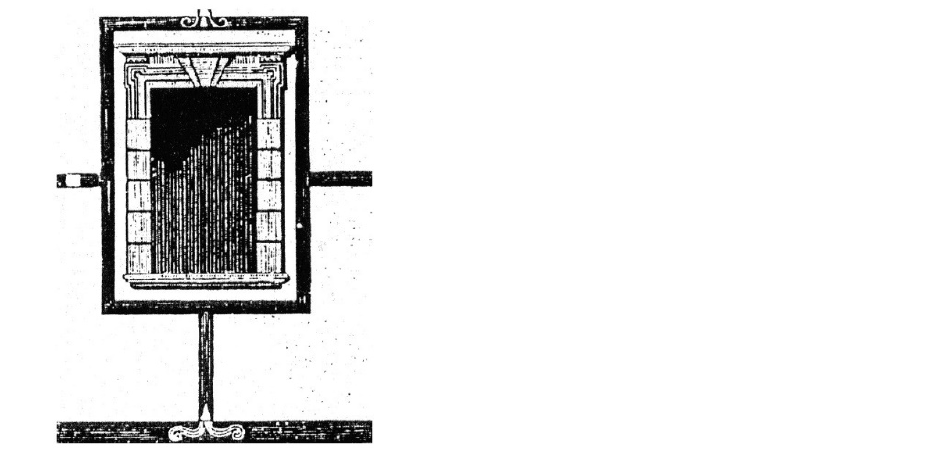
Figure 22. The remains of the sgraffito decoration and the preserved iconographic materials allowed reconstruction of the decorations in a frame arrangement on the facades of the manor house in Stara Kraśnica. Author’s study. Summing up, in the territory of Silesia all types of sgraffito decoration compositions developed in Europe were used, apart from the Tuscan grotesque composition. The unique contribution seems to be the frame system, which is presented in the next part of the article. Let us note, however, for the sake of order that before the appearance of sgraffiti, at the beginning of the first phase of the Silesian Renaissance, newly erected buildings (mainly from burgher foundations) were dominated by the shaping of the façade by means of rich stonework detail with Northern Italian ornamentation and divisions based on the levels of cornices above and below windows. It was only from the middle of 16th century, most probably due to the influx of Ticino, Grisons and Komasków immigrants, that a new façade organization was introduced. Afterwards they began to consciously give up any additional elements, subordinating its structure almost entirely to sgraffito decorations.